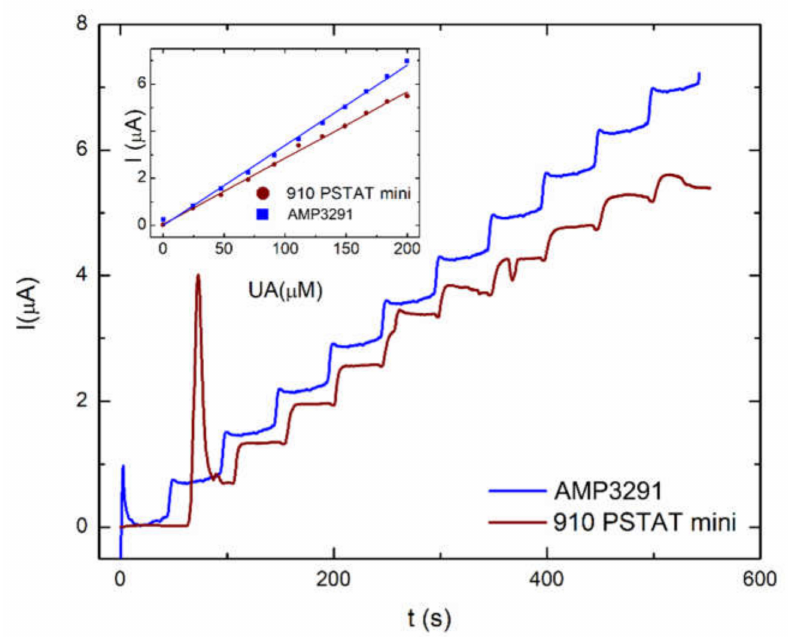
Figure 7. Comparison of the sensing platform in artificial saliva with AMP3291 and 910 PSTAT mini using the